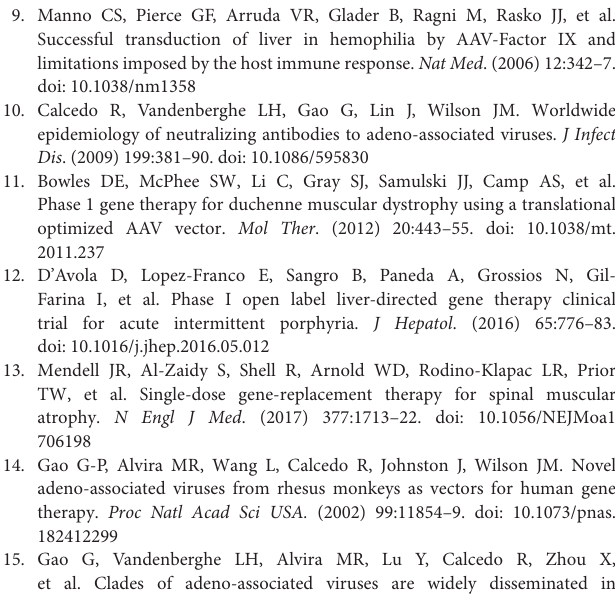
Supplementary Figure 1 | Representative flow cytometry data of donor B cell populations, pre- and post-bead sort. Cells were first gated on CD19 status, and positive cells were evaluated for the presence of CD27 and IgM. Supplementary Figure 2 | Phylogeny of isolated variable heavy chain sequences. Phylogenies of (A) validated and (B) total isolated variable heavy chain sequences. Clones and germline V gene usage are indicated. Figure was generated in AlignX. Supplementary Figure 3 | Phylogeny of isolated variable light chain sequences. Phylogenies of (A) validated kappa, (B) total kappa, (C) validated lambda, and (D) total lambda isolated variable heavy chain sequences. Clones and germline V gene usage are indicated. Figure was generated in